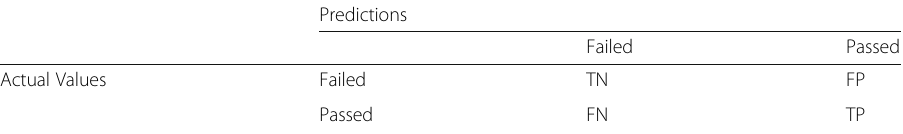
Table 2 Sample Confusion